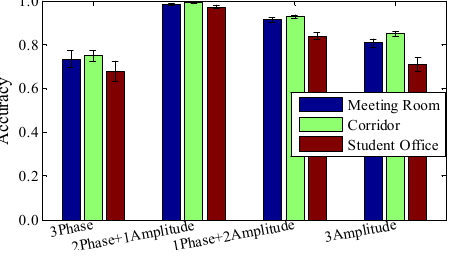
Figure 12. Impact of raw material.